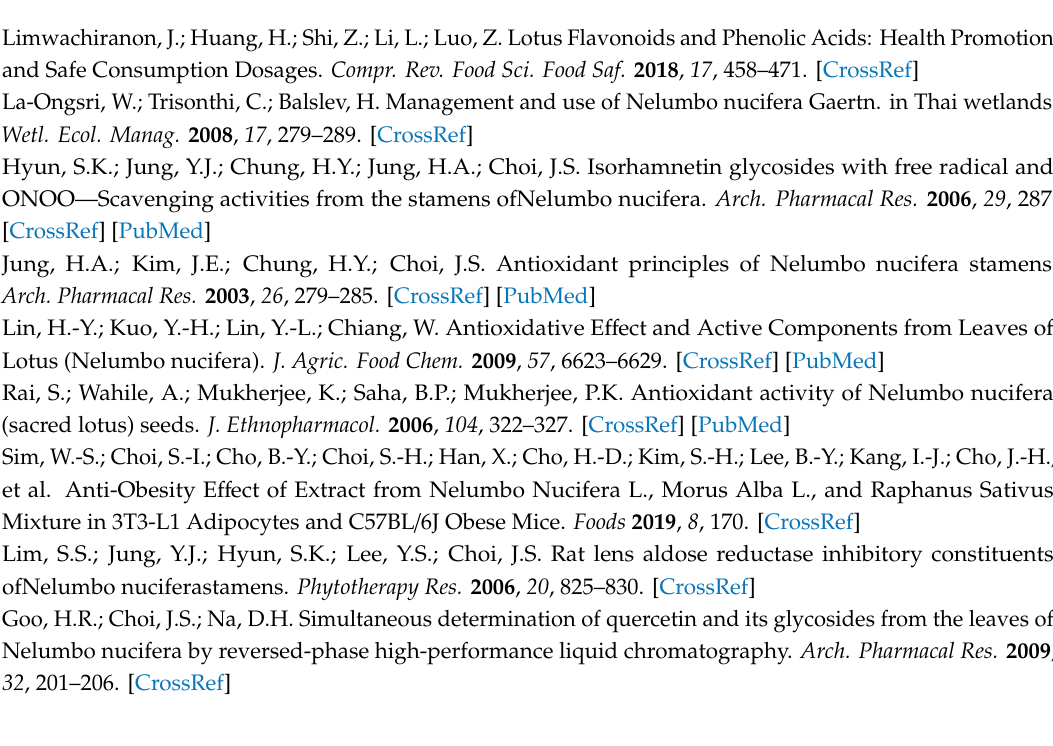
Supplementary Table S1: Color (where L* describes darkness ( − ) to lightness ( + ), a* describes green ( − ) to red ( + ), and b* describes indigo ( − ) to yellow ( + )) and percentage (%) of moisture content of sacred lotus samples.; Supplementary Table S2: The validation parameters of sacred lotus extract detection using HPLC analysis.; Supplementary Figure S1: High-performance liquid chromatograms of (A.) gallic acid, (B.) naringenin and sacred lotus extracts including (C.) seed embryo, (D.) flower stalk, (E.) stamen, (F.) old leaf, (G.) petal, and (H.) leaf stalk. Retention times (Rt) of phenolics in sacred lotus extracts are indicated at a wavelength of 280 nm.; Supplementary Figure S2: High-performance liquid chromatograms of (A.) p-coumaric acid, (B.) ferulic acid and sacred lotus extracts including (C.) seed embryo, (D.) flower stalk, (E.) stamen, (F.) old leaf, (G.) petal, and (H.) leaf stalk. Retention times (Rt) of phenolics in sacred lotus extracts are indicated at a wavelength of 325 nm.; Supplementary Figure S3: High-performance liquid chromatograms of (A.) luteolin, and sacred lotus extracts including (B.) seed embryo, (C.) flower stalk, (D.) stamen, (E.) old leaf, (F.) petal, and (G.) leaf stalk. Retention times (Rt) of phenolics in sacred lotus extracts are indicated at a wavelength of 338 nm.; Supplementary Figure S4: High-performance liquid chromatograms of (A.) myricetin, (B.) quercetin, (C.) kaempferol, (D.) isorhamnetin and sacred lotus extracts including (E.) seed embryo, (F.) flower stalk, (G.) stamen, (H.) old leaf, (I.) petal, and (J.) leaf stalk. Retention times (Rt) of phenolics in sacred lotus extracts are indicated at a wavelength of 368 nm.; Supplementary Figure S5: High-performance liquid chromatograms of (A.) cyanidin, (B.) delphinidin and sacred lotus extracts including (C.) seed embryo, (D.) flower stalk, (E.) stamen, (F.) old leaf, (G.) petal, and (H.) leaf stalk. Retention times (Rt) of phenolics in sacred lotus extracts are indicated at a wavelength of 530 nm.; Supplementary Figure S6: Scheme showed the IC50 plots against acetylcholinesterase (AChE) of sacred lotus extracts including (A.) seed embryo, (B.) flower stalk, (C.) stamen, (D.) old leaf, (E.) petal, and (F.) leaf stalk.; Supplementary Figure S7: Scheme showing the IC50 plots against butyrylcholinesterase (BChE) of sacred lotus extracts including (A.) seed embryo, (B.) flower stalk, (C.) stamen, (D.) old leaf, (E.) petal, and (F.) leaf